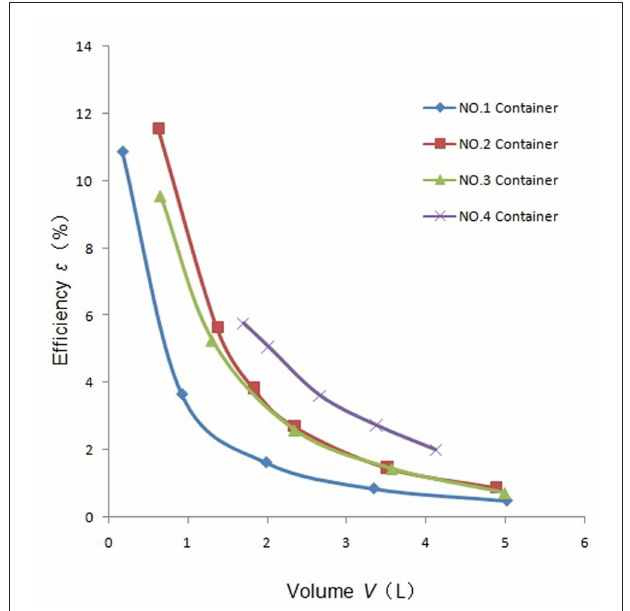
FIGURE 5 | Coincidence efficiency vs. container volume (simulation results).